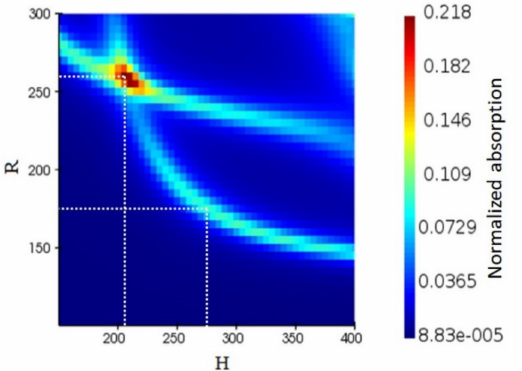
Figure 2. The normalized light absorption of the Ge PIN photodiode as a function of radius (R) and height (H) of the disk for the excitation wavelength of 1550 nm. The first is for R 1 = 175 nm and H 1 = 275 nm which corresponds to the magnetic dipole resonance. The second configuration is for R 2 = 260 nm and H 2 = 205 nm and corresponds to the overlap between the electric anapole state and magnetic dipole, giving rise to the absorption enhancement.